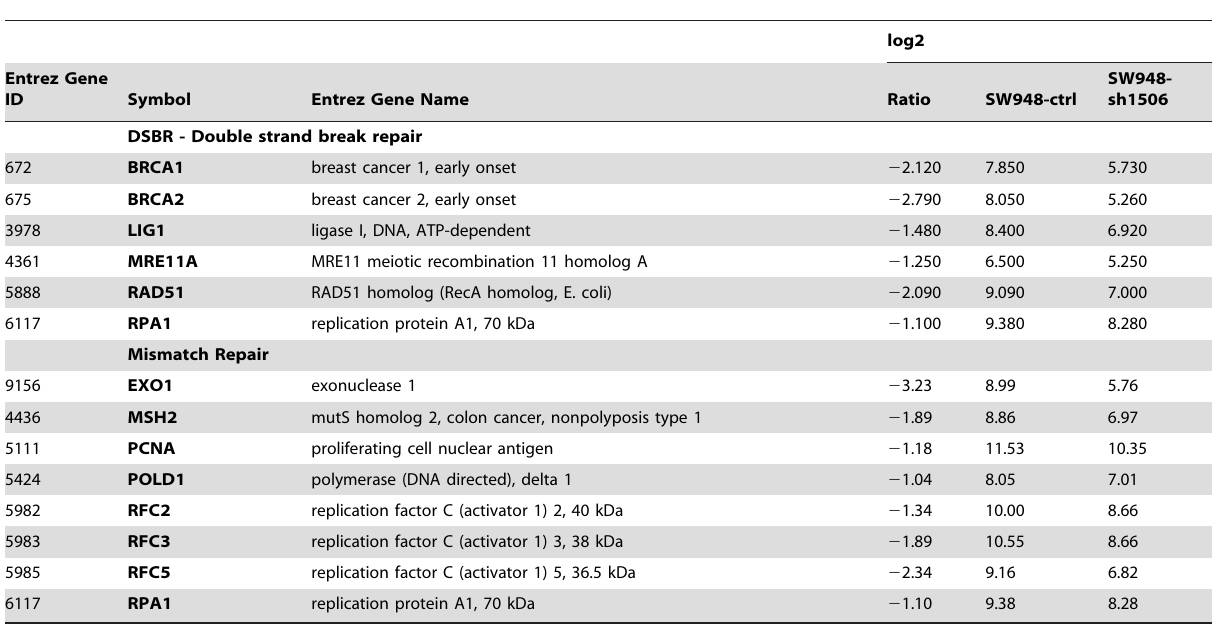
Table 2. KRT23 knockdown affects canonical pathways involved in DNA damage